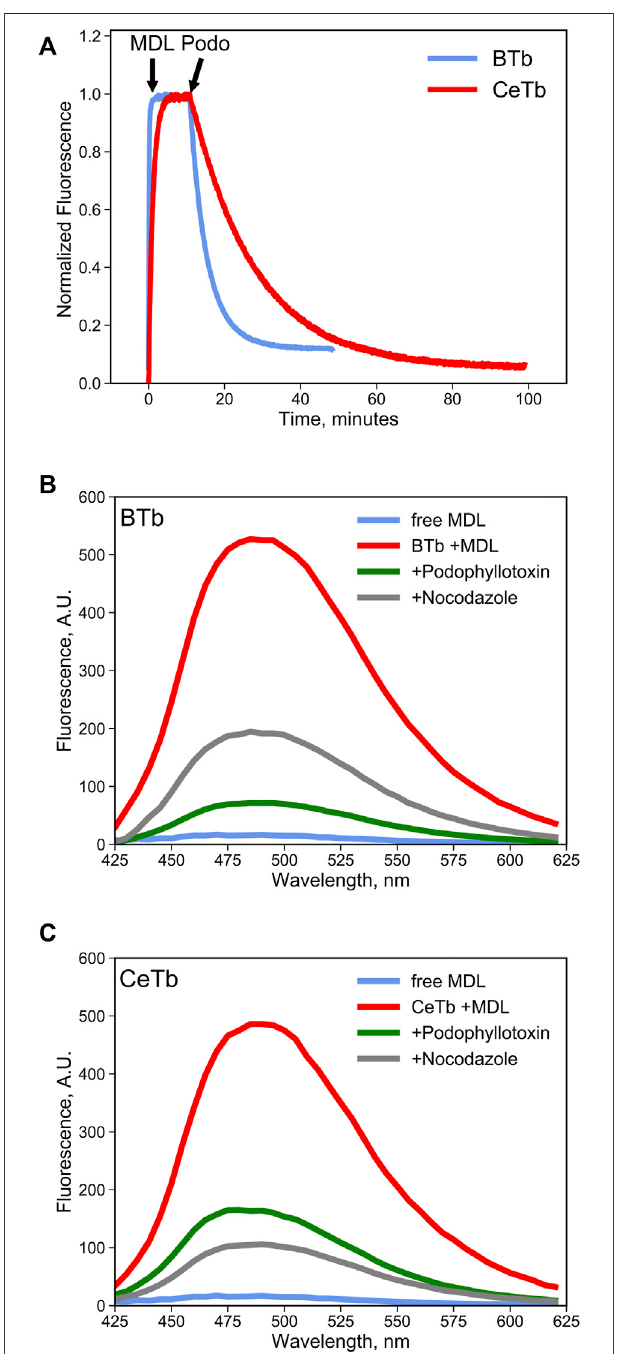
FIGURE3| inPMbufferpriortoadditionof10 µMMDL.ThedecreaseinMDL fl uorescence is evidence the competitive binding by the selected drugs that displaces the fl uorescent molecule from the colchicine site in